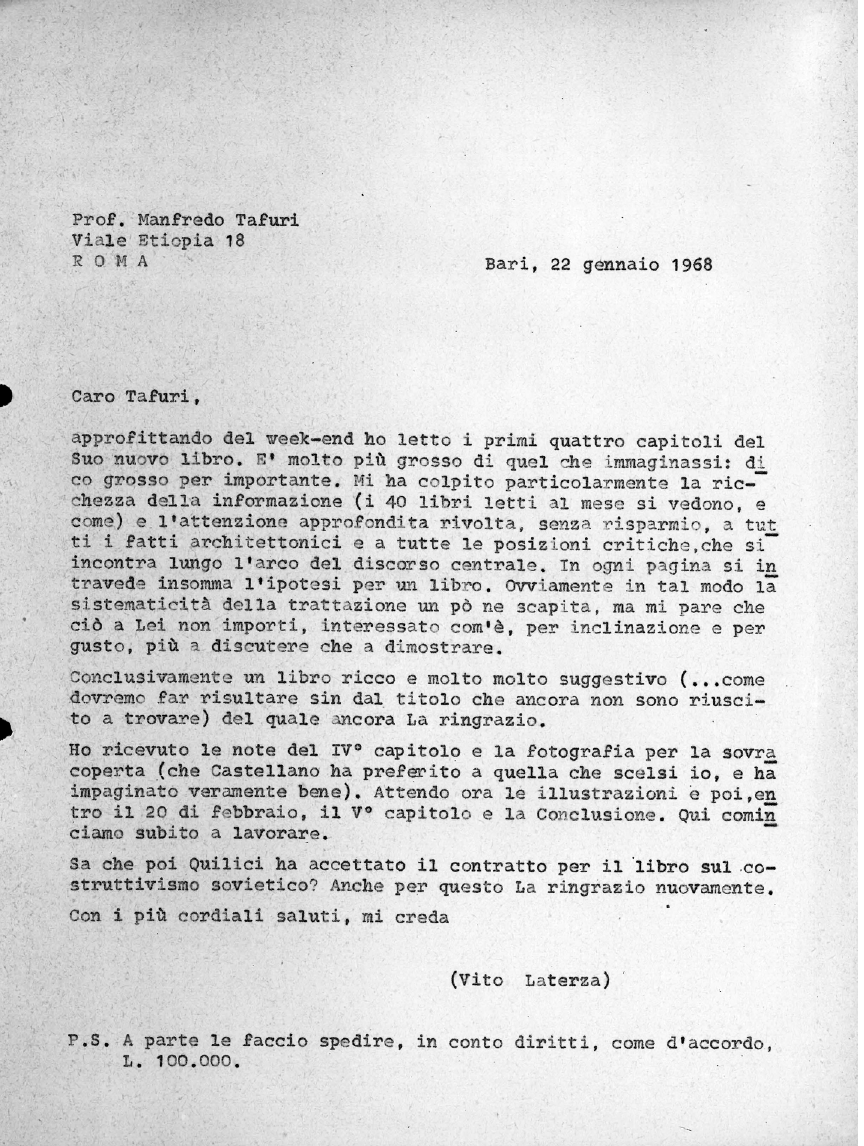
Vito Laterza, typewritten letter to Manfredo Tafuri.